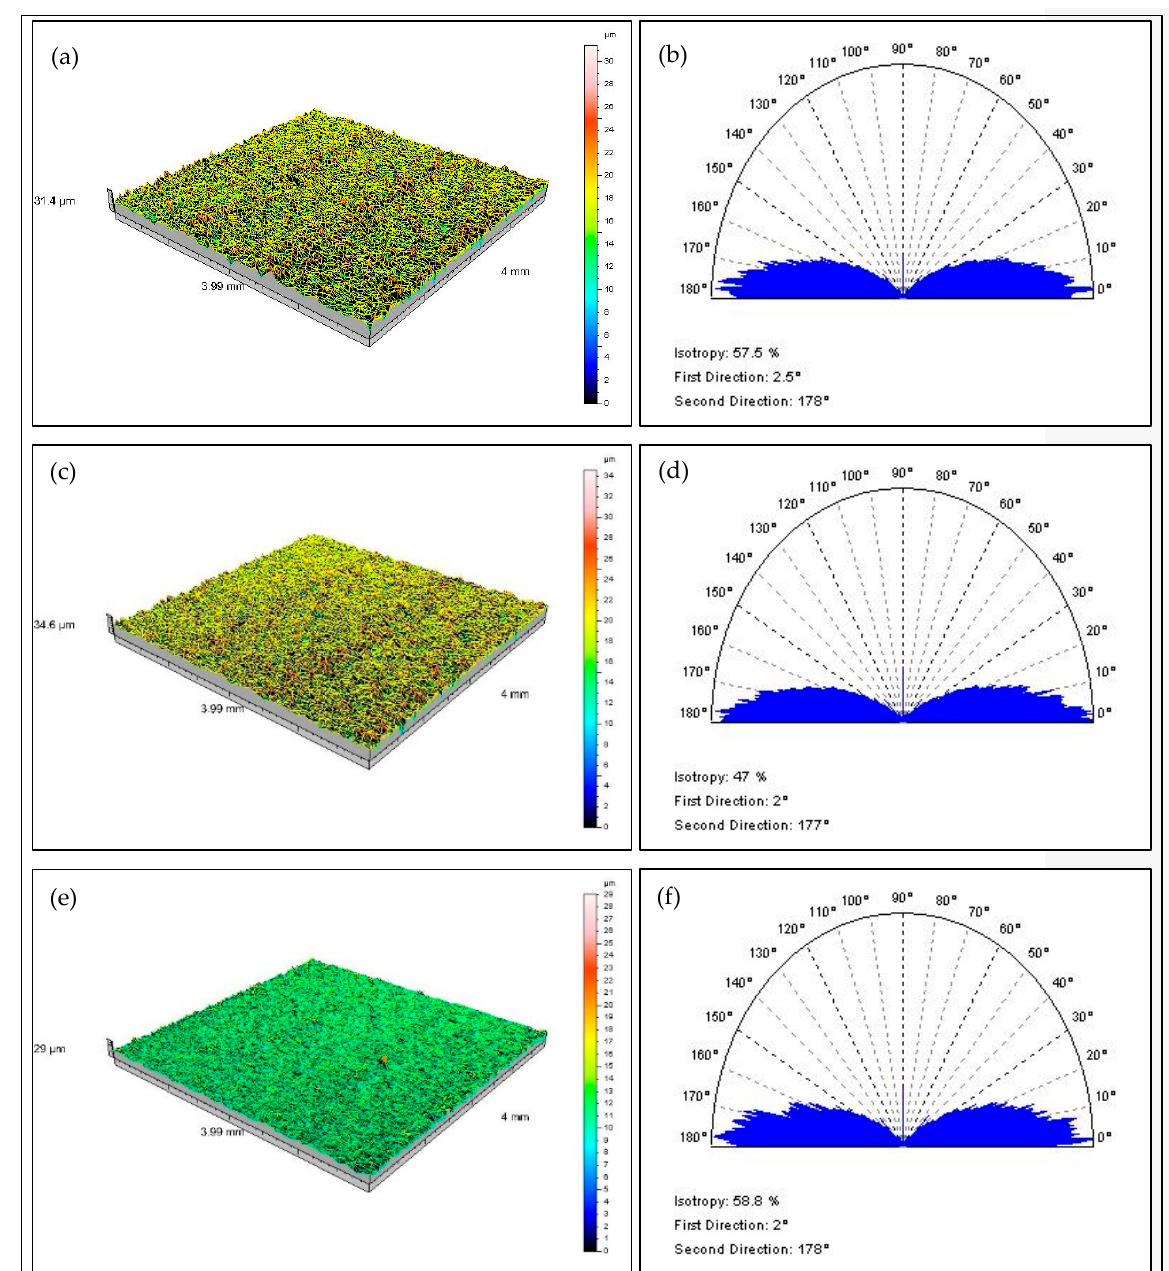
Figure 10. 3D surface views and the orientation plots of some samples after 30 min machining by CDF without movement ( a ) and ( b ); with rotational movement ( c ) and ( d ); with rotation and oscillating movement ( e ) and ( f ).